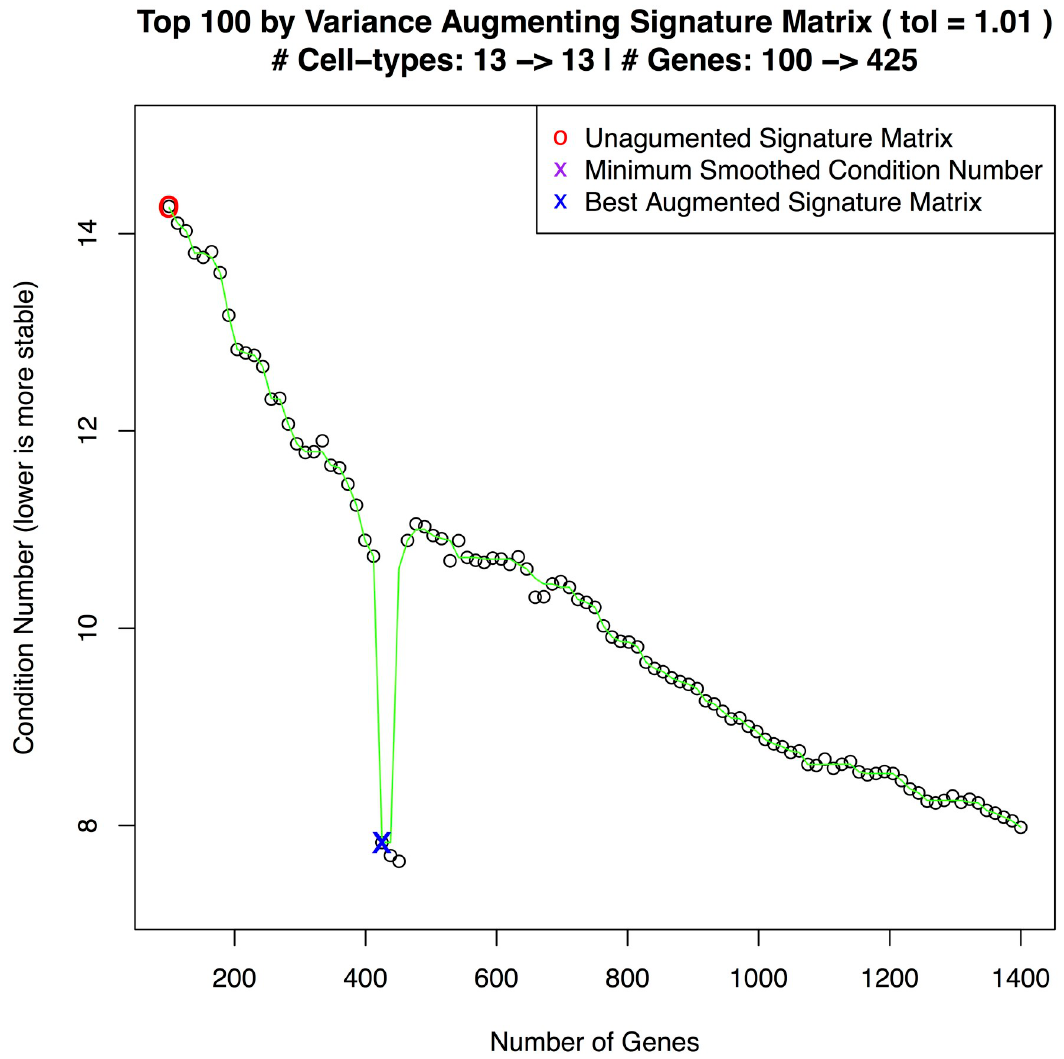
Fig 5. scRNAseq signature matrix construction. Curve showing the selection of an optimal condition number for the single cell RNAseq augmented signature matrix data.